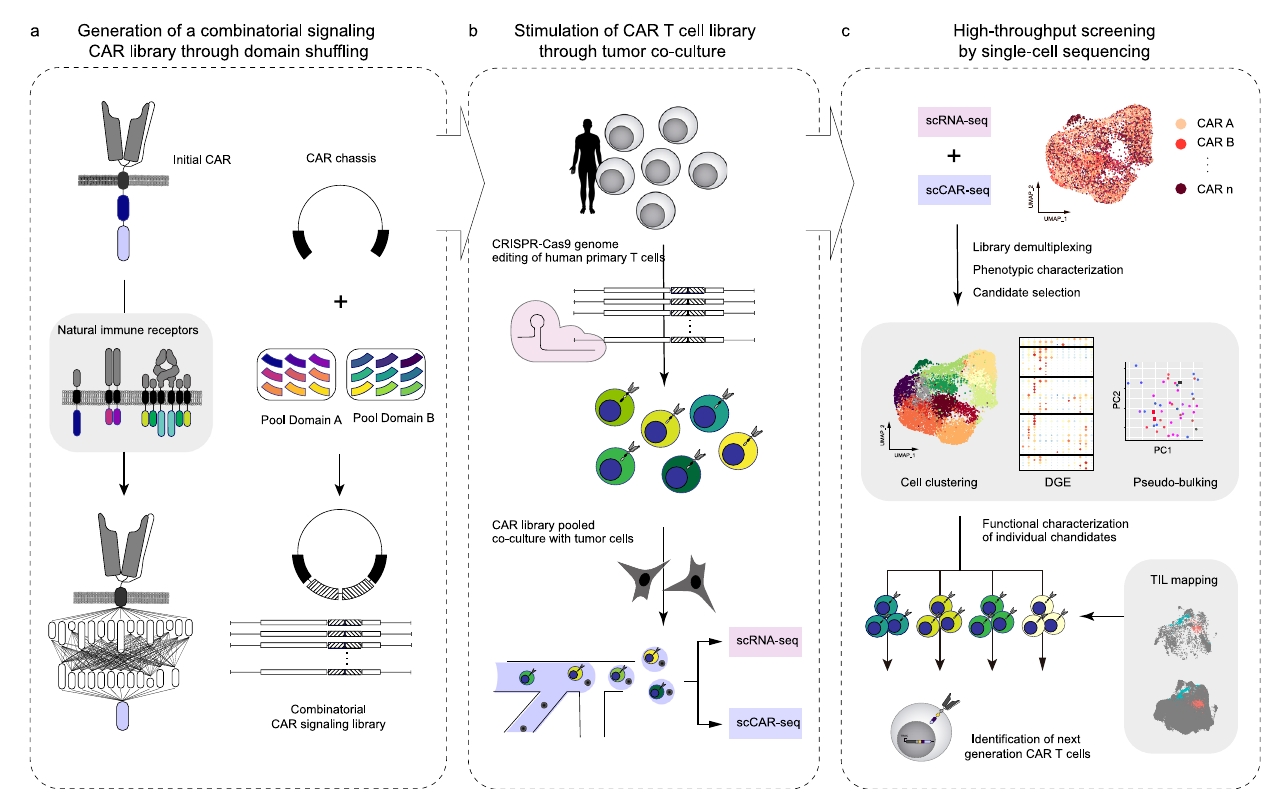
Fig. 5 | Functional characterization of selected CAR variants con fi rms their diverse phenotypes and potential enhanced properties. a Ten CAR signaling domain variants were selected for individual characterization along with the clini- callyused28zandBBzCARs. b ProportionofTcelldifferentiationsubsetsobserved inCAR orTCR-negative(TCR-)Tcellsfollowinga4dayco-culturewithSKBR3cells (4:1 E:T ratio)asmeasured byCD62Land CD45RAsurface expression(naive T cells (Tn), stem central memory T cells (Tscm), central memory T cells (Tcm), Effector MemoryTcells(TEM),EffectorMemoryRA-positiveTcells(TEMRA)). c Proportion of CAR or TCR- T cells simultaneously expressing different number of exhaustion markers (PD1, TIM3, TIGIT, LAG3, and CTLA4) following the co-culture conditions described in b . d , e CAR T cell-mediated cytotoxicity of HER2+/GFP+tumor cells quanti fi ed over time by fl uorescence microscopy. The fl uorescence change values represent the difference in GFP intensity compared to time point 0, and a dashed line represents the baseline where no GFP+cells are left. CAR T cells were co-